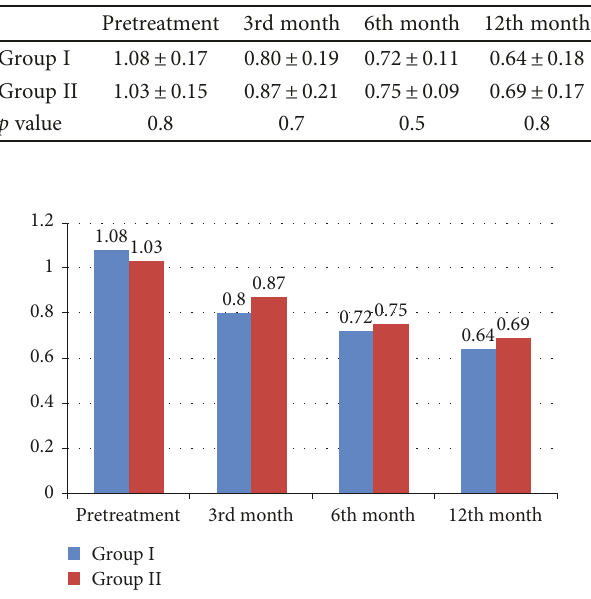
Figure 3: BCVA measured by LogMAR in patients of both groups.